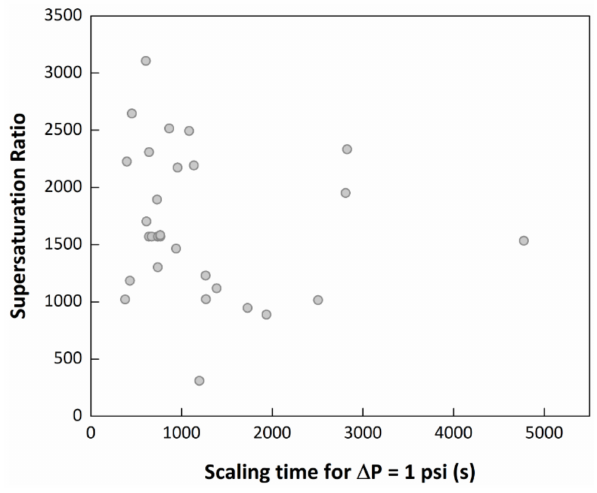
Figure 7. Graph of the scaling time versus the supersaturation ratio for the experiments in the design of